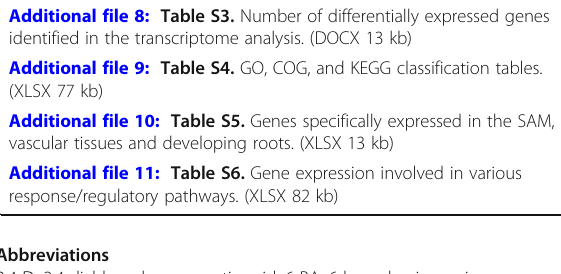
Additional file 8: Table S3. Number of differentially expressed genes identified in the transcriptome analysis. (DOCX 13 kb) Additional file 9: Table S4. GO, COG, and KEGG classification tables. (XLSX 77 kb) Additional file 10: Table S5. Genes specifically expressed in the SAM, vascular tissues and developing roots. (XLSX 13 kb) Additional file 11: Table S6. Gene expression involved in various response/regulatory pathways. (XLSX 82